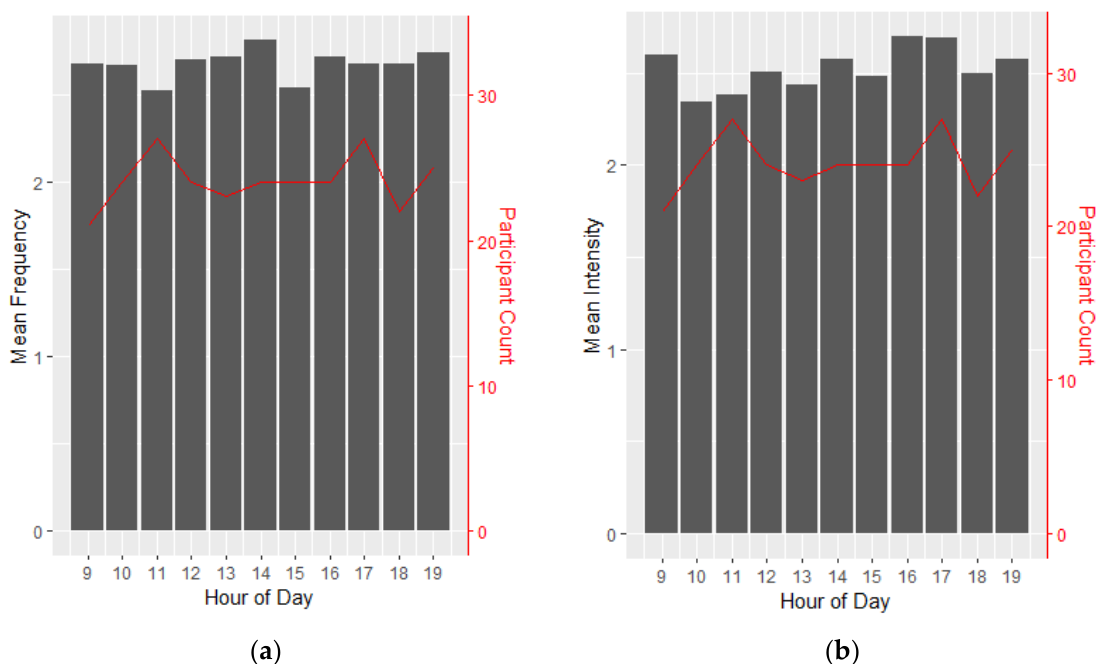
Figure 6. Tic Frequency and Intensity Throughout the Day. ( a ) Mean tic frequency per hour, with number of participants with results in each hour shown on right axis. Frequency is drawn from surveys filled out before turning on device and random surveys where device was not on. ( b ) Mean tic intensity per hour, with number of participants with results in each hour shown on right axis.